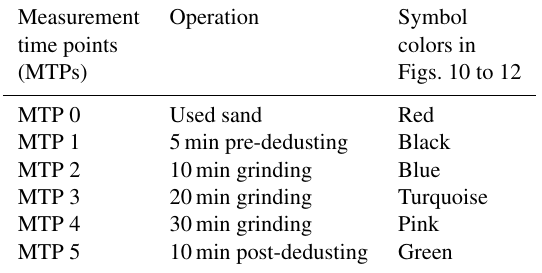
Table 2. Measurement times at which a regenerate sample was drawn from the regenerator and characterized impedimetrically. The samples belonging to these MTPs were measured with the measur- ing cell from Fig. 5b.